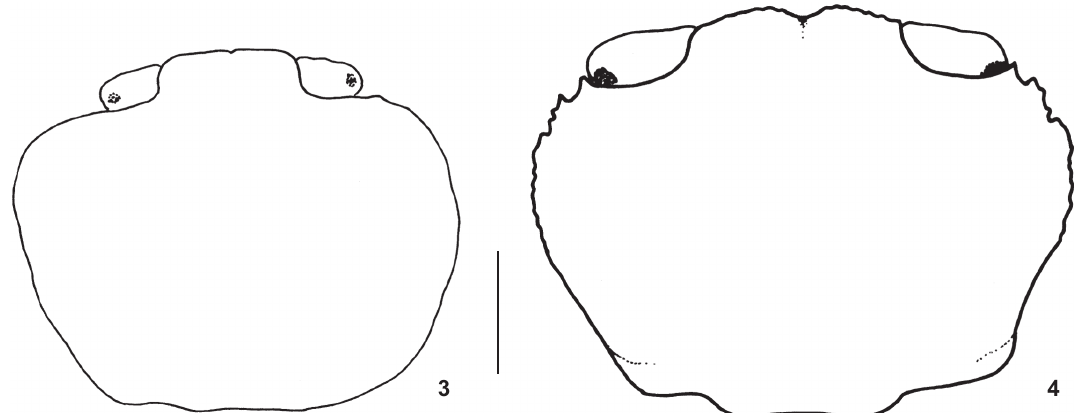
Figures 3-4. Kingsleya ytupora : dorsal view of carapace of first (3) and second juveniles (4) encountered on the abdomen of females. Scale bar: 1